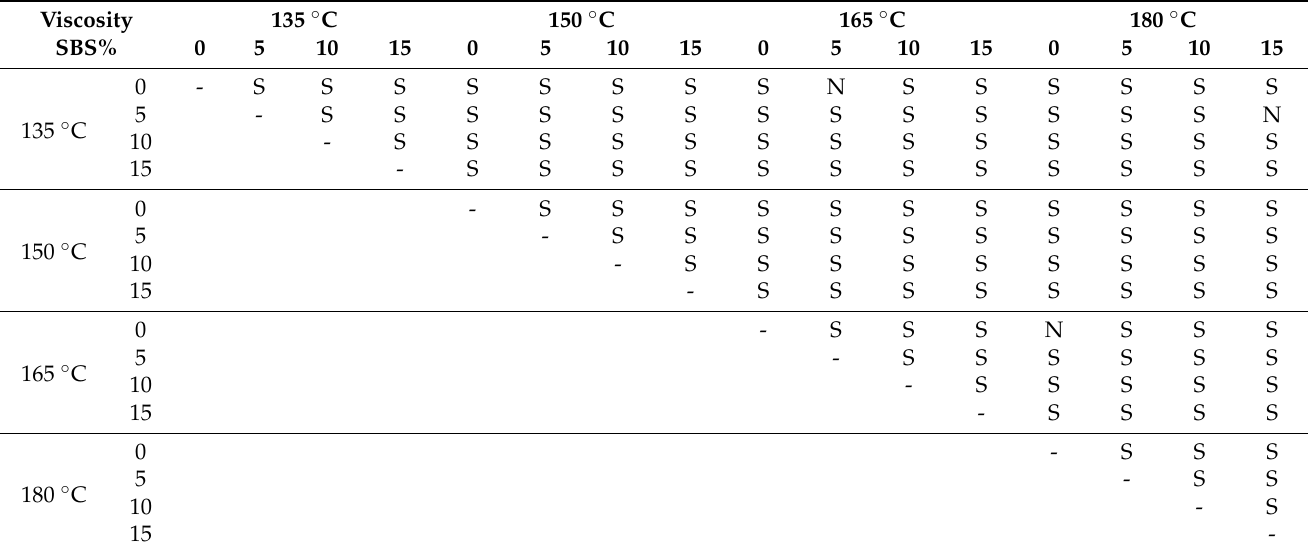
Table 6. Statistical analysis results of viscosity for PG 64-22 with 6% processed oil as a function of SBS content ( α =